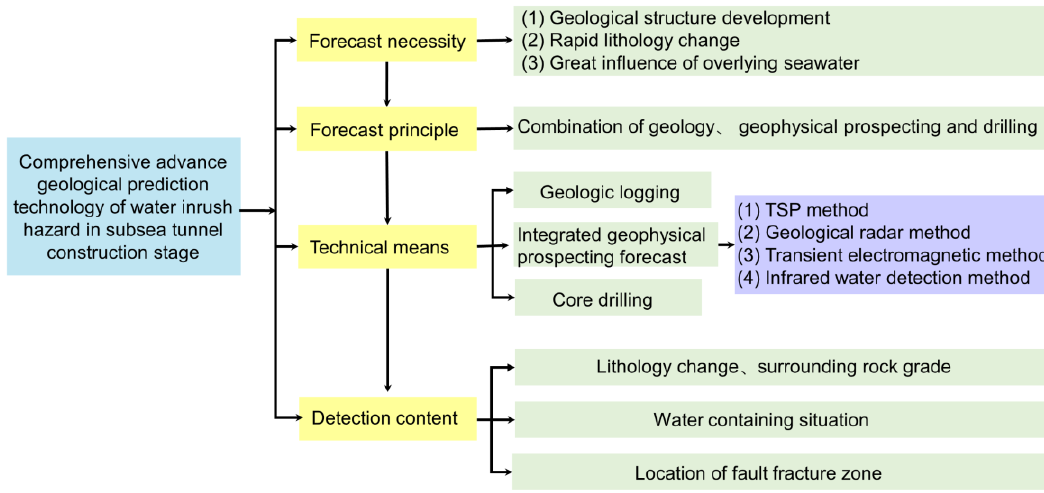
Figure 25. Comprehensive advanced geological prediction technology system for a subsea tunnel [164].